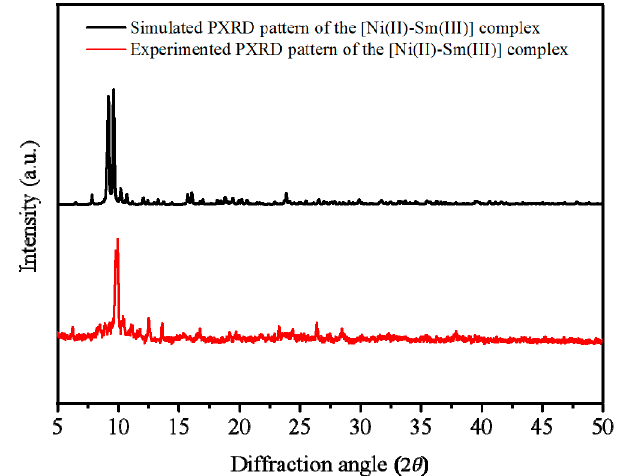
Figure 1. Comparing the simulated PXRD and experimental patterns of the [Ni(II)-Sm(III)] coordination polymer.